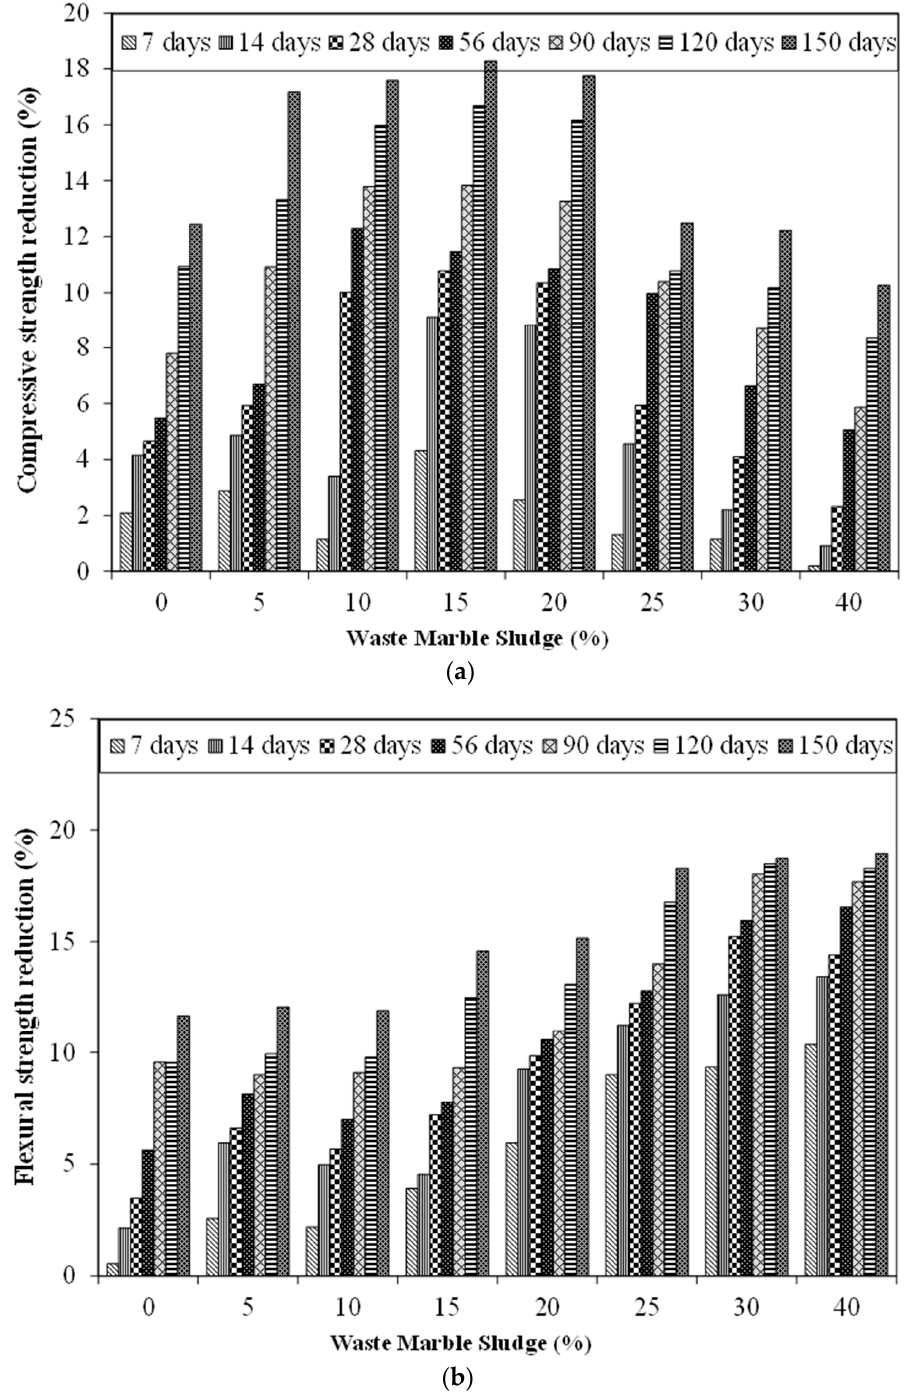
Figure 7. Effect of ASR on MS mortar specimens ( a ) compressive strength reduction due to ASR ( b ) flexural strength reduction due to ASR.